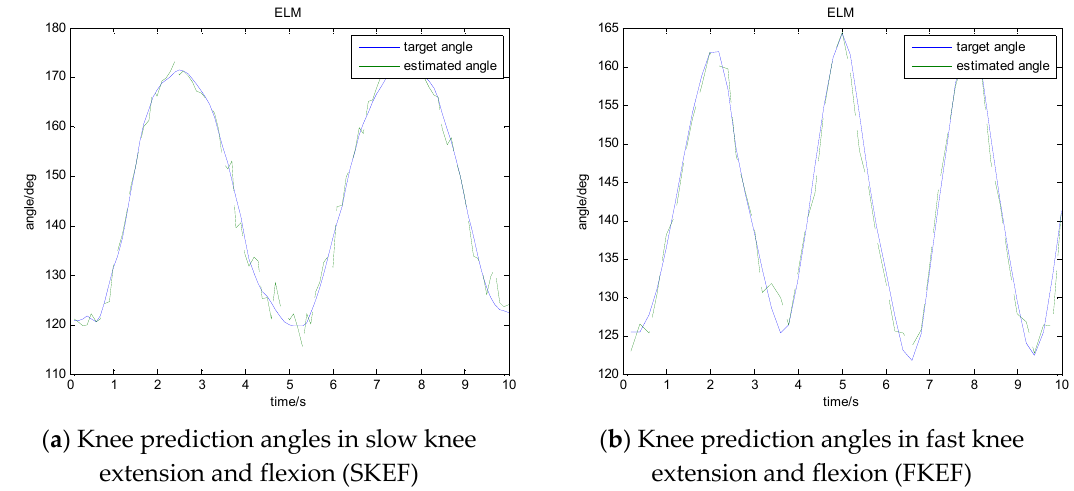
Figure 16. Prediction results of knee extension and flexion.